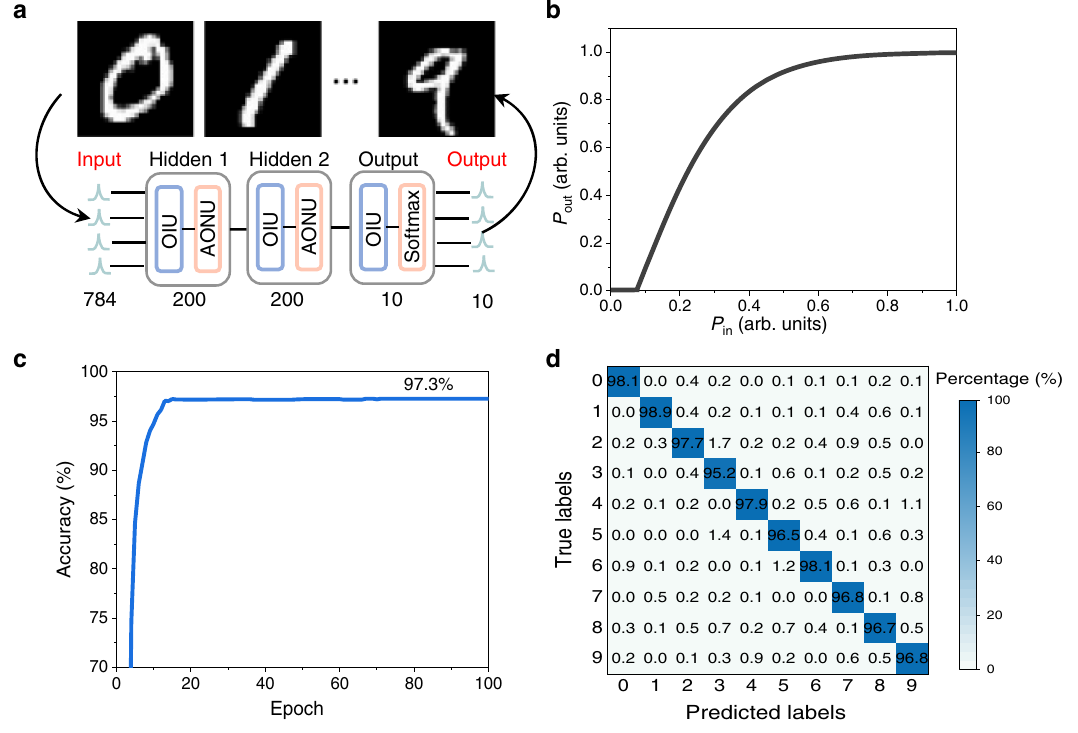
Fig. 5 | Handwriting recognitionwitha deep feedforward AONN. a The 10digits and the structure of the neural nwtwork. OIU, optical linear unit, is a series of weightingsbetweenneuronsinthesoftware. b Theactivationfunctionsnormalized